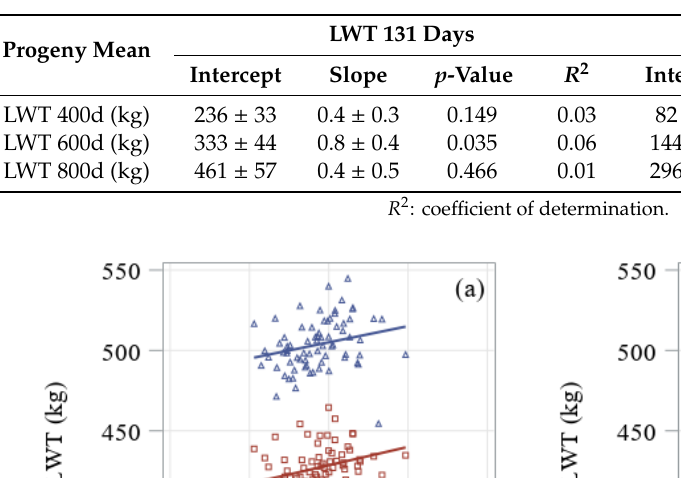
Table 3. Estimates of regression coe ffi cients (intercept and slope) of least-squares means of the progeny groups for live weight (LWT, in kilograms) at 400, 600 and 800 days of age, on least-squares means of the progeny groups for live weight at 131 or 200 days of age, for 73 sires.